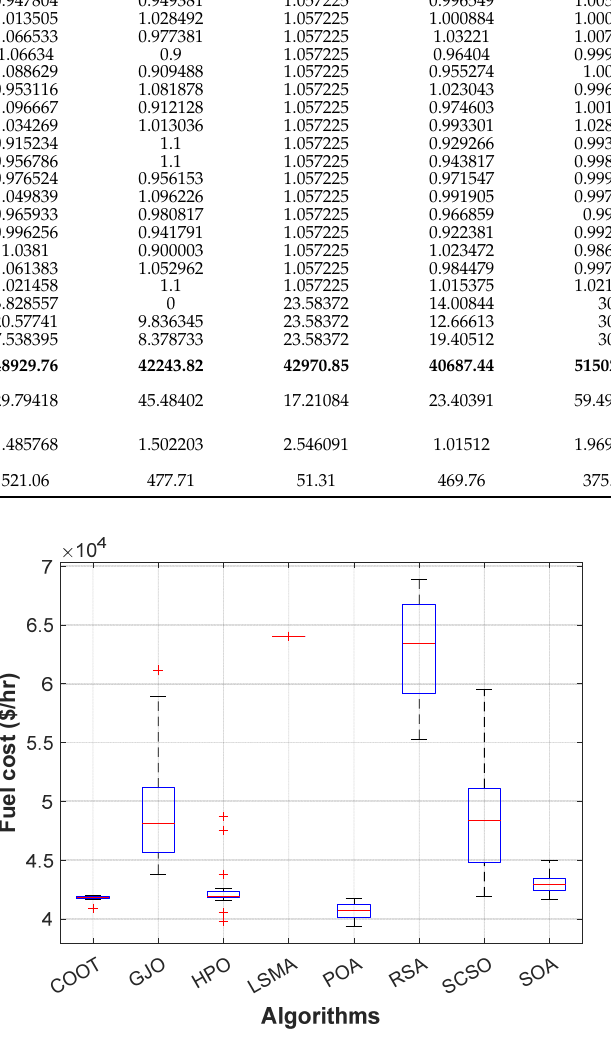
Figure 21. Boxplot of POA and other compared algorithms for case 1 in a standard IEEE 57-bus test system.